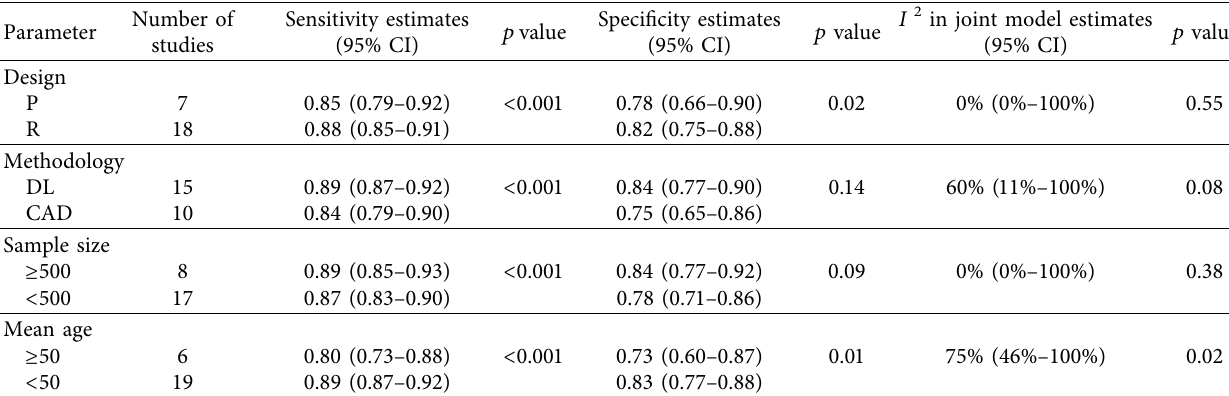
Table 3: Meta-regression for heterogeneity within